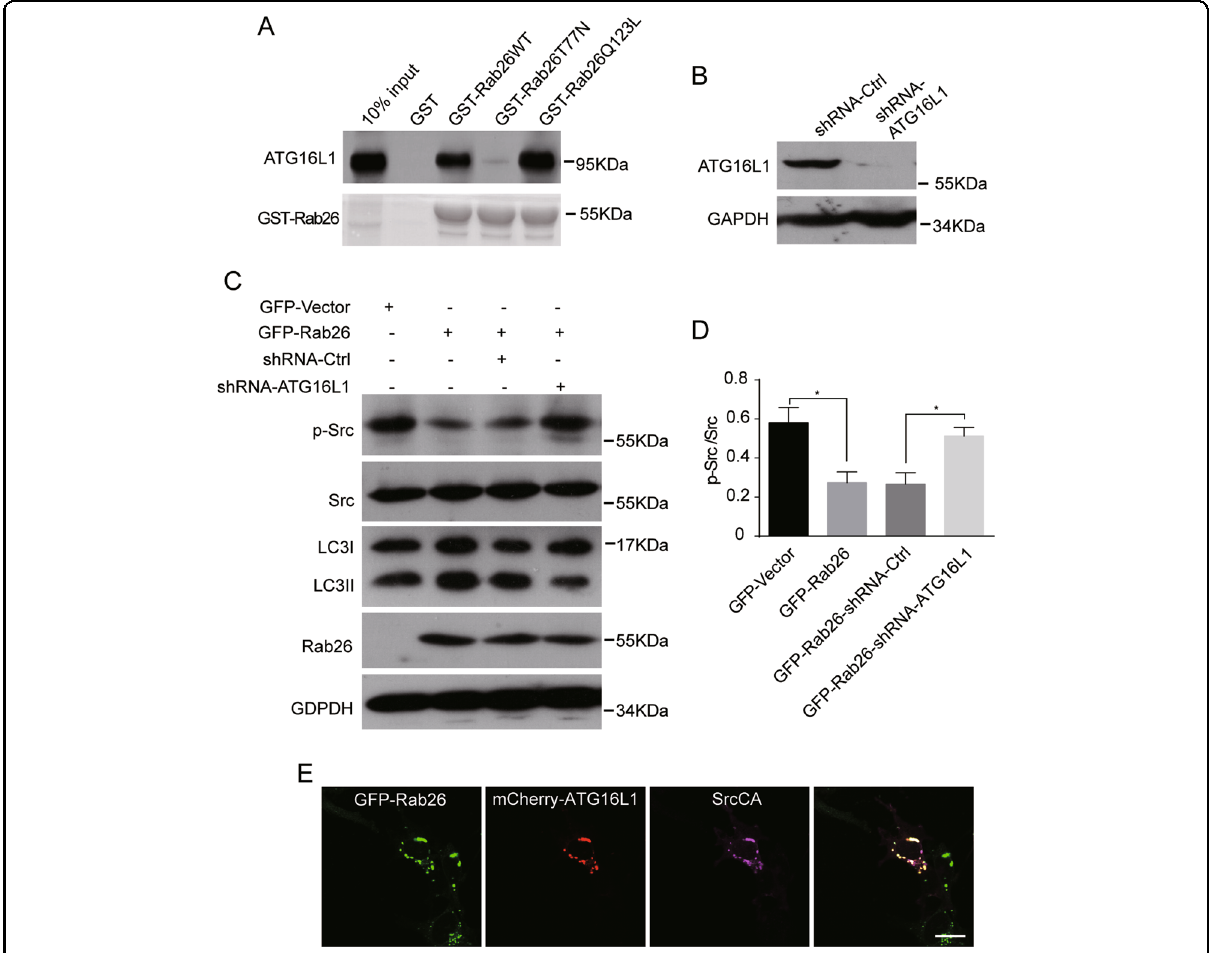
Fig. 7 Rab26 mediates the autophagic degradation of phosphorylated Src depending on the interaction with ATG16L1. A GST pull-down and western-blot assay demonstrated that Rab26 interacts with ATG16L1. B Western blot showed ATG16L1 is ef fi ciently depleted by the pSicoR-GFP lentiviral system in MDA-MB-231 cells. C Western blot demonstrated that ATG16L1 knockdown in Rab26 over-expressed cells restores phosphorylated Src levels. D Quantitative analysis of the results of C from three independent experiments. * p < 0.05. E GFP-Rab26 associates with mCherry-ATG16L1 at autophagosomes. Bar = 20